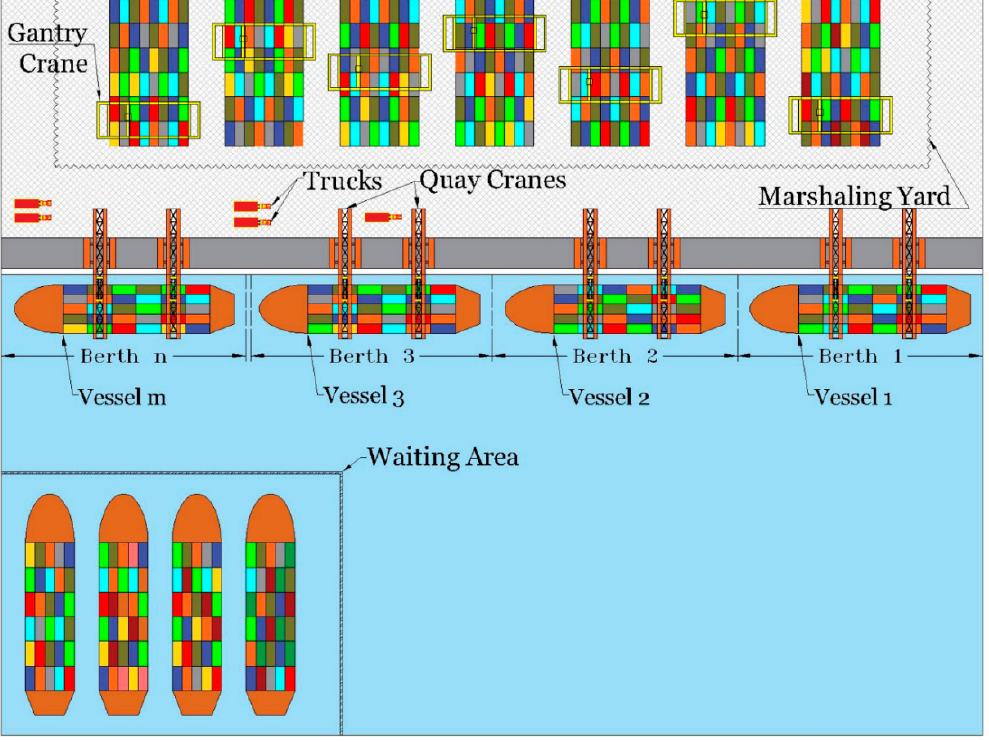
Figure 2. Layout of the considered MCT.